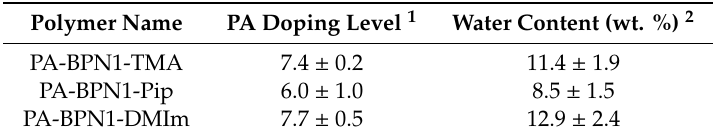
Table 1. PA doping level and water content of PA-BPN1-QA polymers.